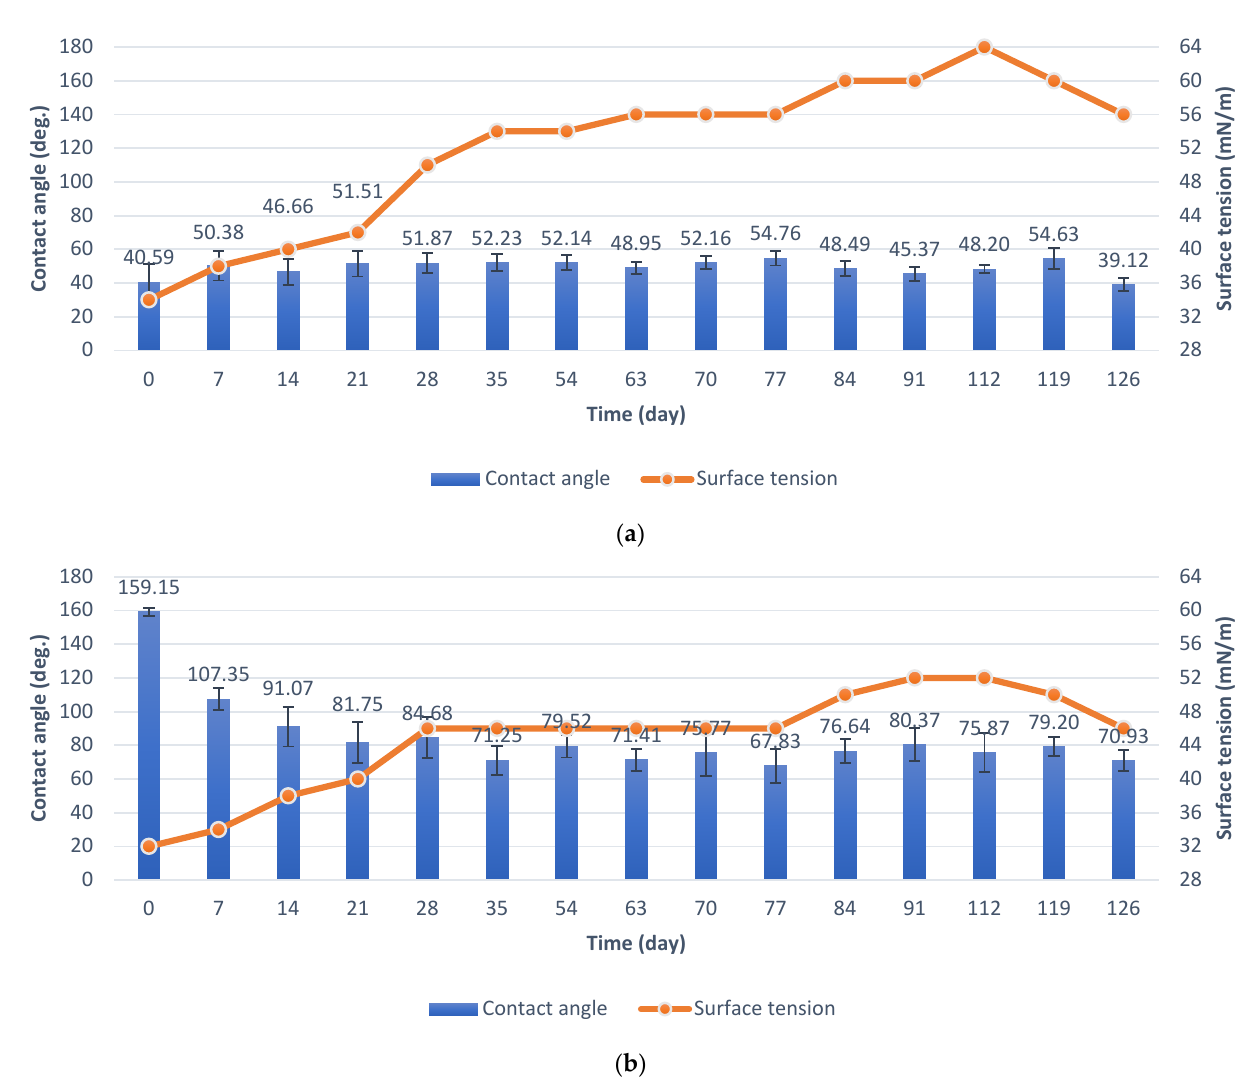
Figure 9. Contact angle and surface tension during the test in the pond: ( a ) specimens from Series 1, ( b ) specimens from Series 2.